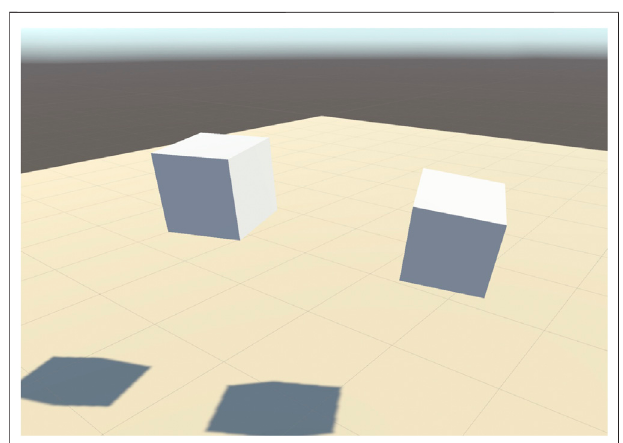
FIGURE2 | The fi gure shows thethird person view oftwoabstract cube avatars in the brainstorming task.